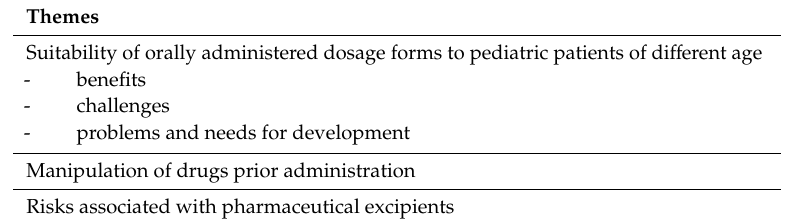
Table 1. Interview guide for the focus group discussions about oral drug administration